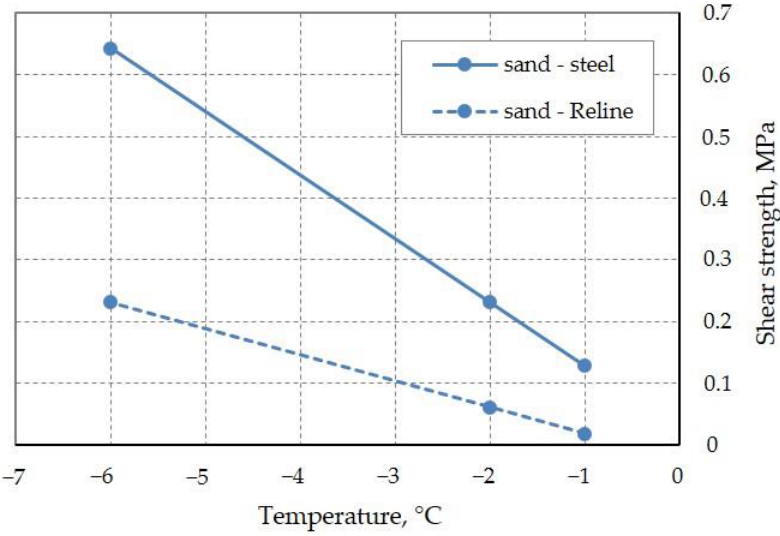
Figure 7. Temperature dependence of shear strength: sand-steel and sand- Reline .